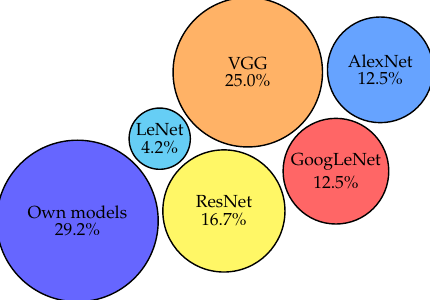
Figure 7. General distribution of CNN architectures used for fruit image